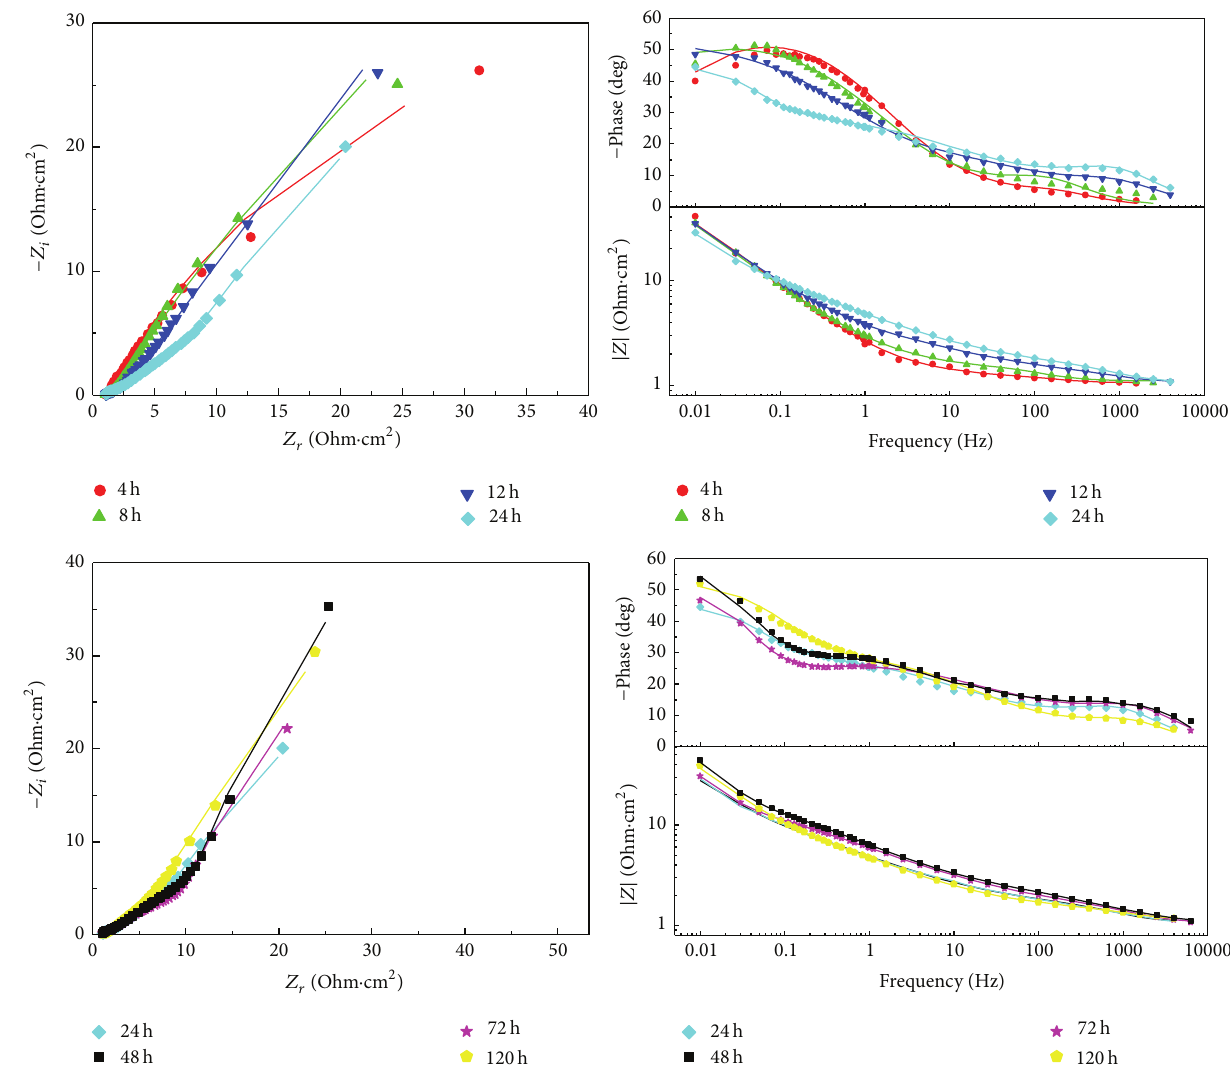
Figure 3: Nyquist and Bode plots of SS310 in molten carbonate at 650 ∘ C in air. Scattered points are measured data and lines are simulated